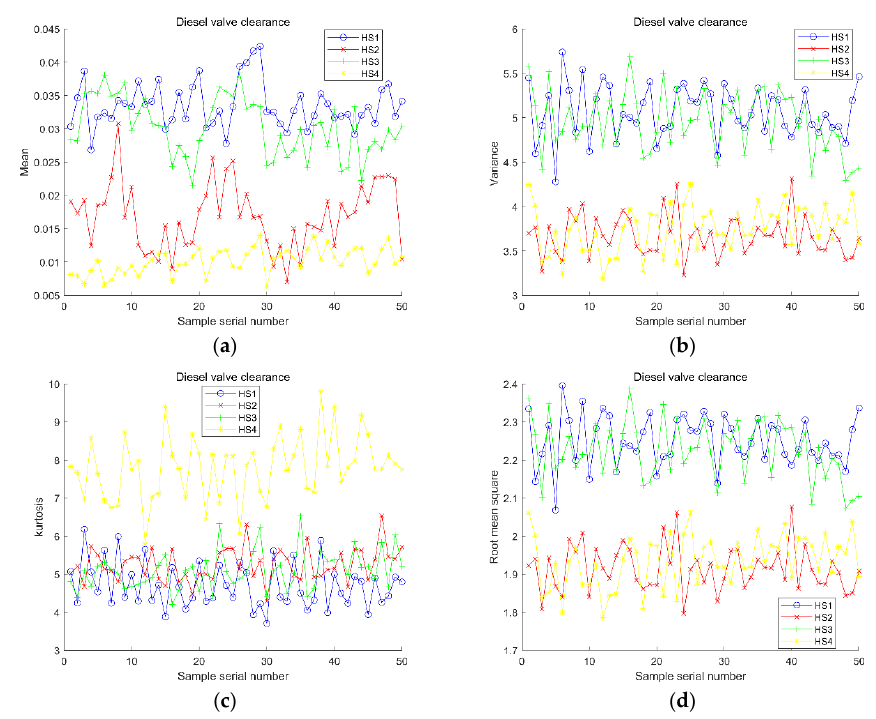
Figure 10. Variation trend graph of characteristic parameters. ( a ) Mean; ( b ) Variance; ( c ) Kurtosis; ( d ) Root mean square.